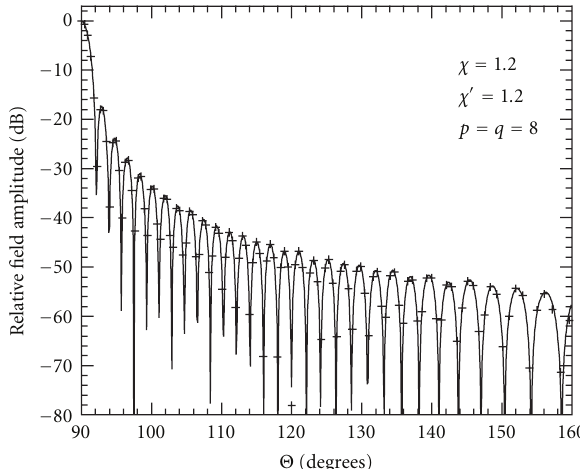
Figure 8: E-plane pattern. Solid line: exact. Crosses: recovered from the irregularly spaced helicoidal NF